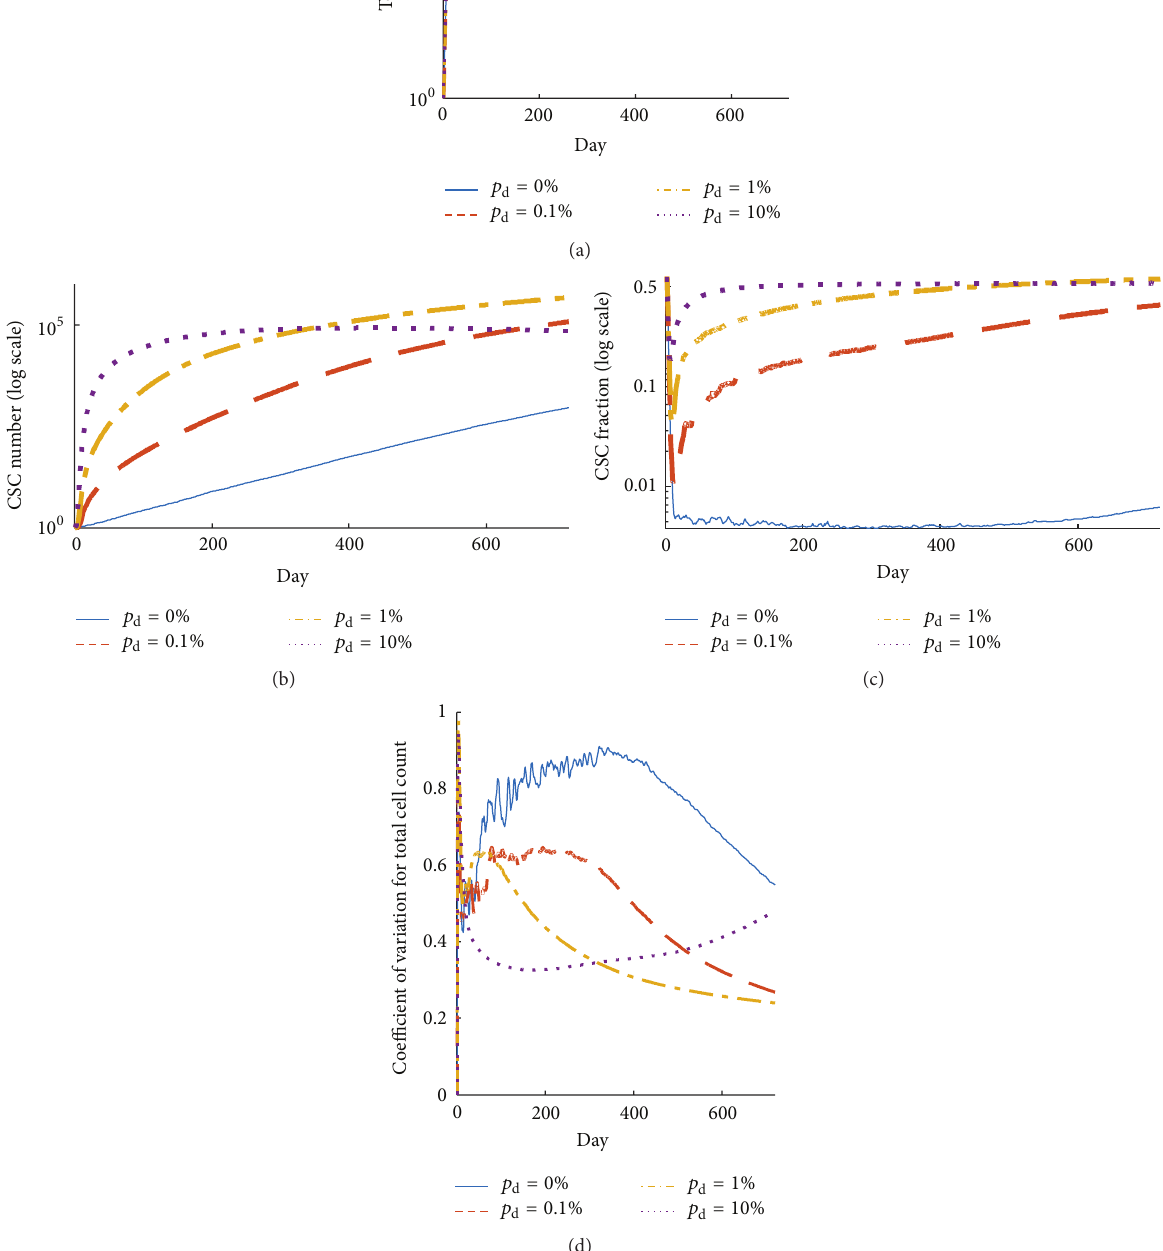
Figure 2: Average total cell count (a), cancer stem cell (CSC) number (b) and fraction (c), and coefficient of variation, that is, standard deviation/mean, for the total cell count (d) as a function of time for tumor without plasticity ( 𝑝 d = 0 %, blue solid curve) and with plasticity probability of 0.1% (red dashed curve), 1% (yellow dot-dashed curve), and 10% (purple dotted curve). Shown are means from 100 simulation runs (only successfully grown tumors are considered). Error bars are omitted for